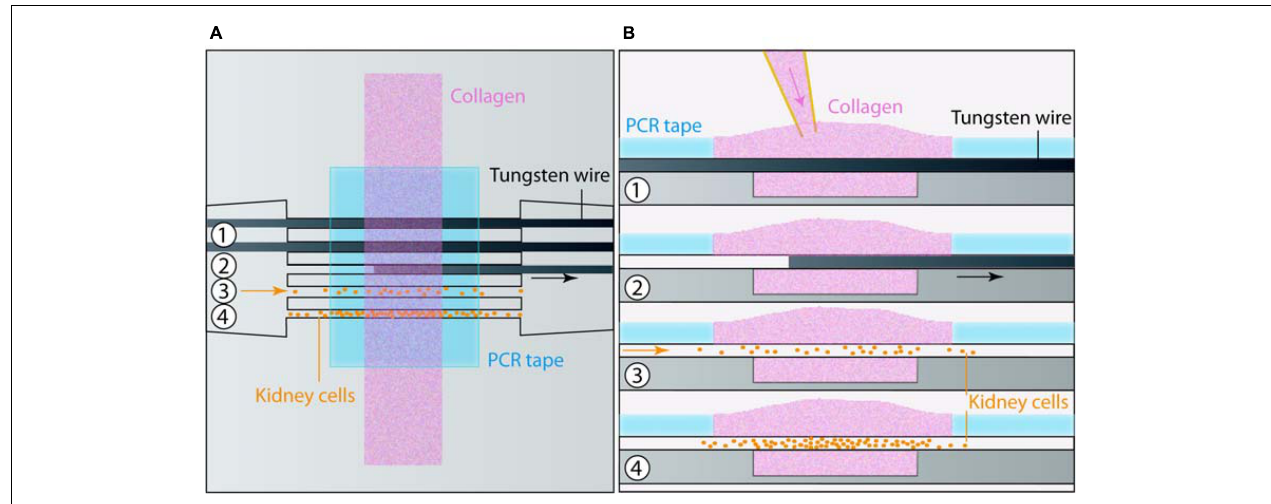
FIGURE 1 | Chip microfabrication and cell seeding. (A) Top and (B) side views of the sequential steps for microfabrication and cell seeding: (1) Collagen was poured on top of the tungsten wires placed in a micromold and maintained by PCR tape. (2) Wires were removed. At this stage an additional coating could be applied. (3) Cells were seeded in tubes, and (4) colonized it in a few